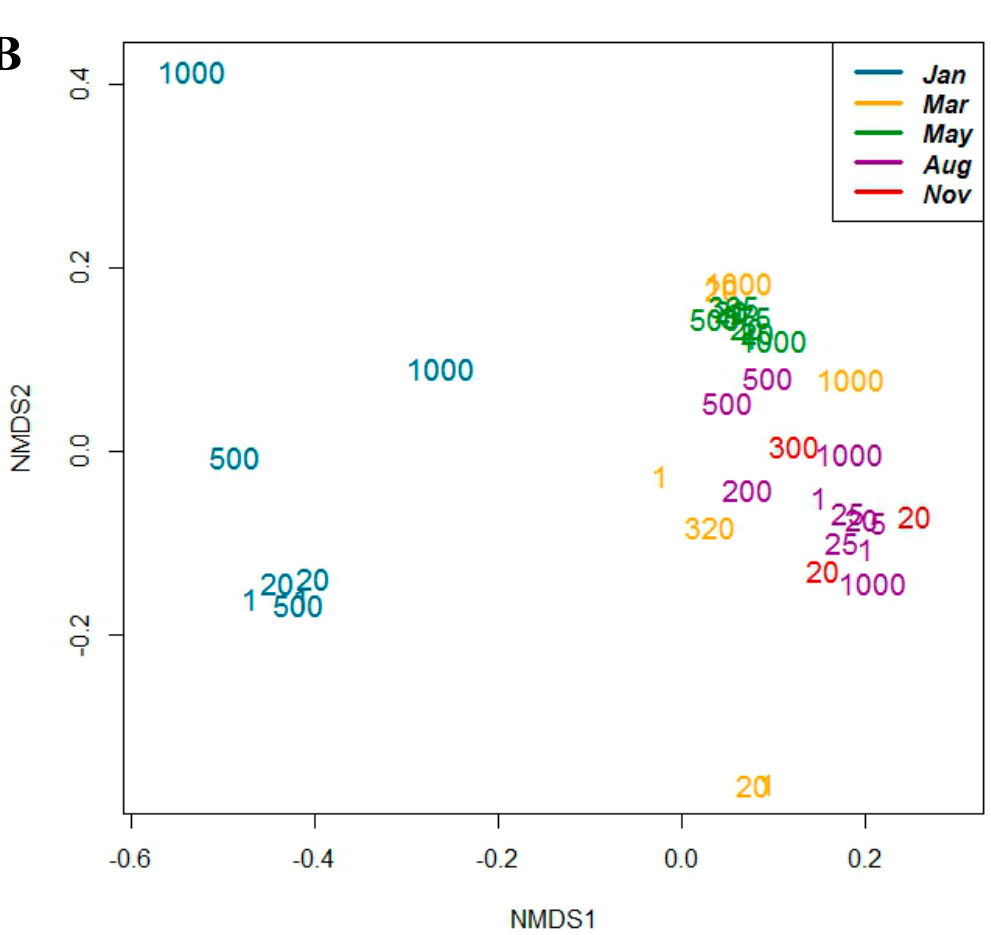
Figure 7. Nonmetric multidimensional scaling (NMDS) analysis of OTU diversity for ( A ) g23 and ( B ) mcp genes. Numbers indicate sampling depth (m), and colors indicate sampling month. Samples clustered together based on similarity in OTU composition (Bray–Curtis dissimilarity), and the axes indicate separation between samples.